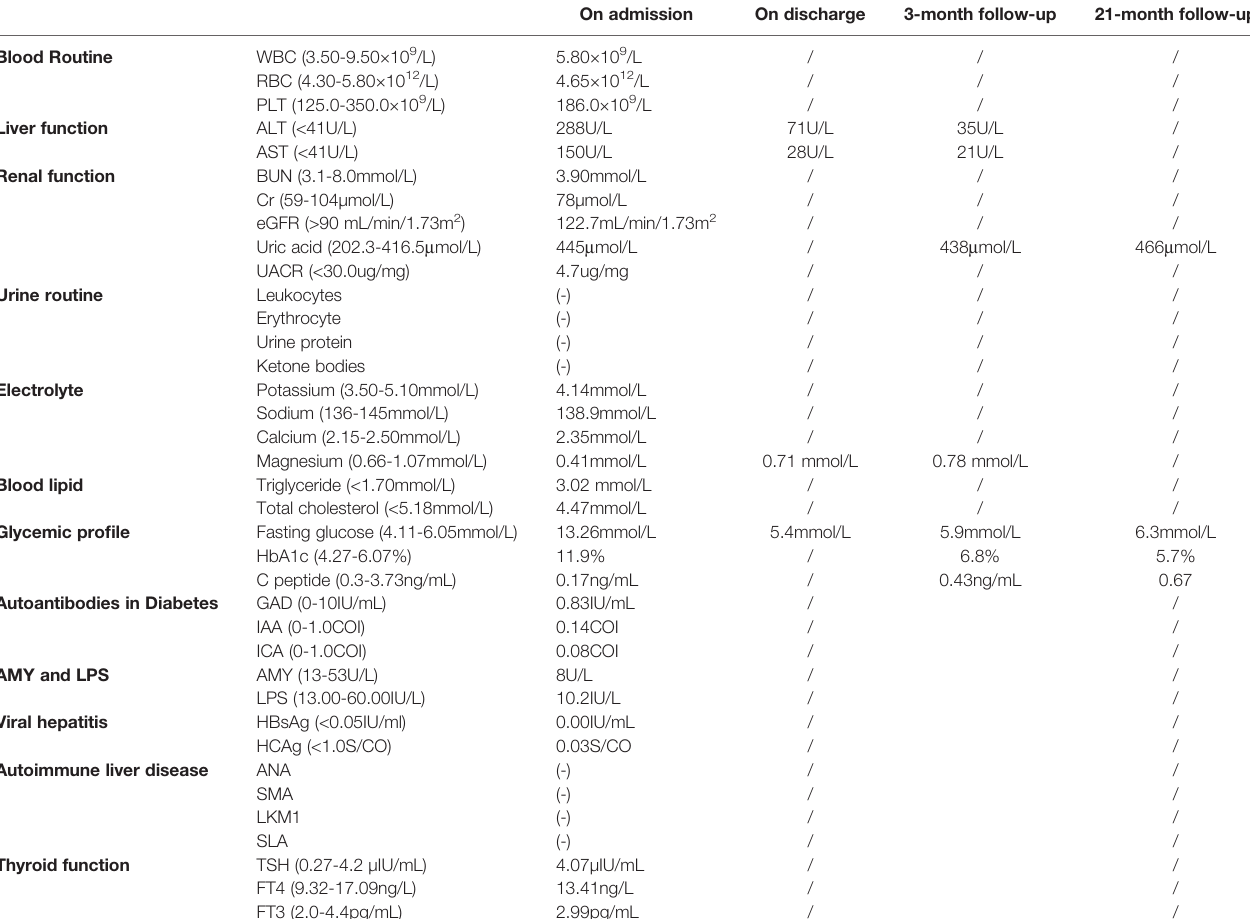
TABLE 1 | Laboratory examinations at the time of admission and